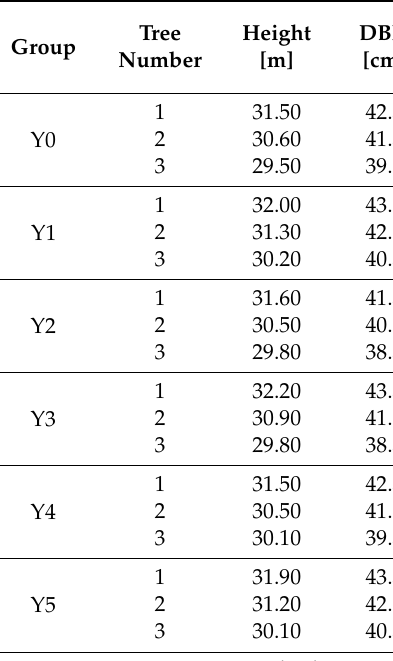
Table 1. Basic locality and stand characteristics.